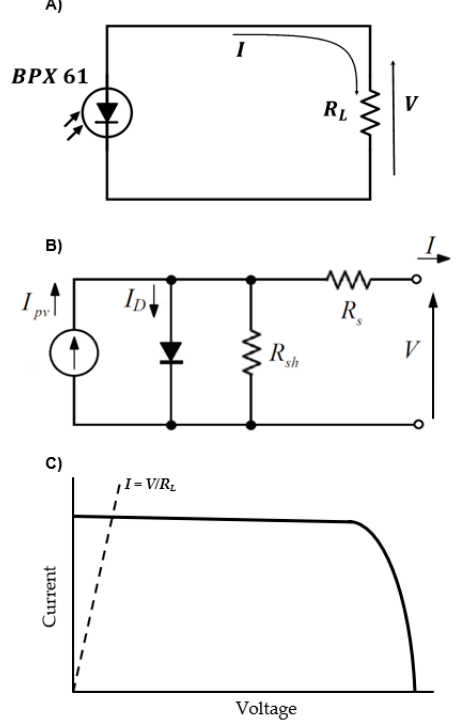
Figure 6. ( A ) Sketch of the electric circuit composed to measure the I–V curve of the photodiodes. ( B ) 1-Diode/2-Resistor equivalent electrical model used for the photodiode. ( C ) I–V operating curve of a photodiode.